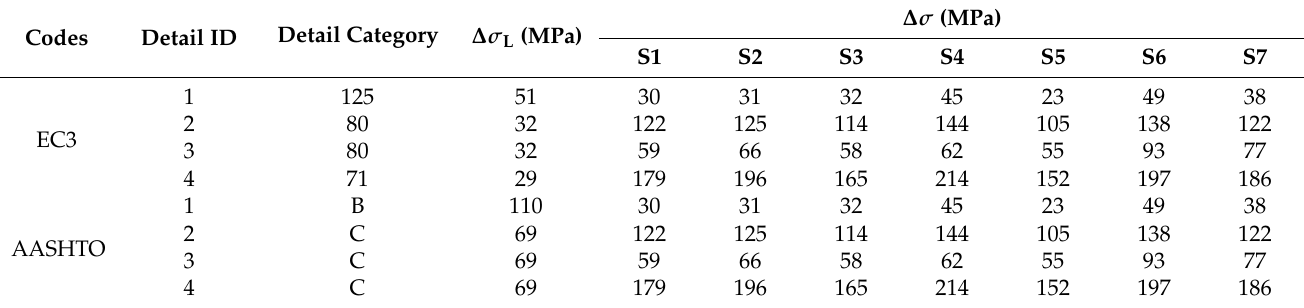
Table 3. Stress amplitude of four details of FE models.